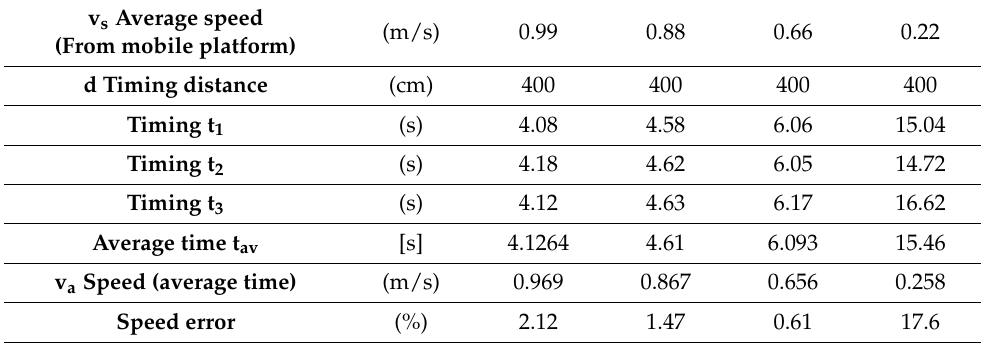
Table 7. Speed measurement with ambient light intensity of 265 lux and white target.